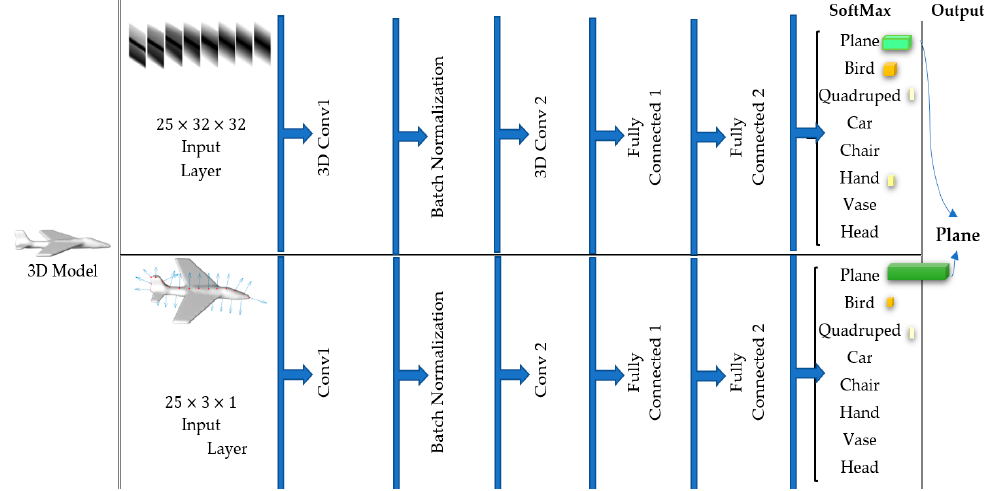
Figure 7. The two convolutional neural network (CNN) structures and the decision on output class.